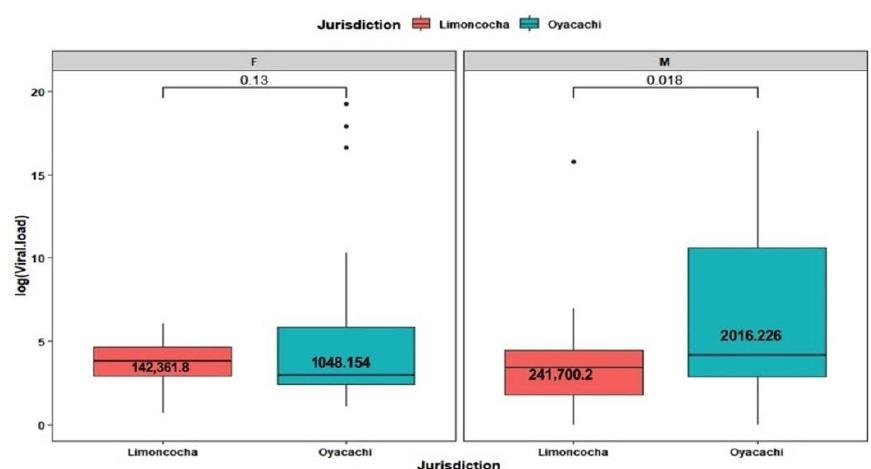
Figure 3. Box plot of viral load composition across jurisdiction (communities) and gender of SARS-CoV-2 test positivity among 108 tested people, 21 women and 29 men from Limoncocha and 30 women and 28 men from Oyacachi.